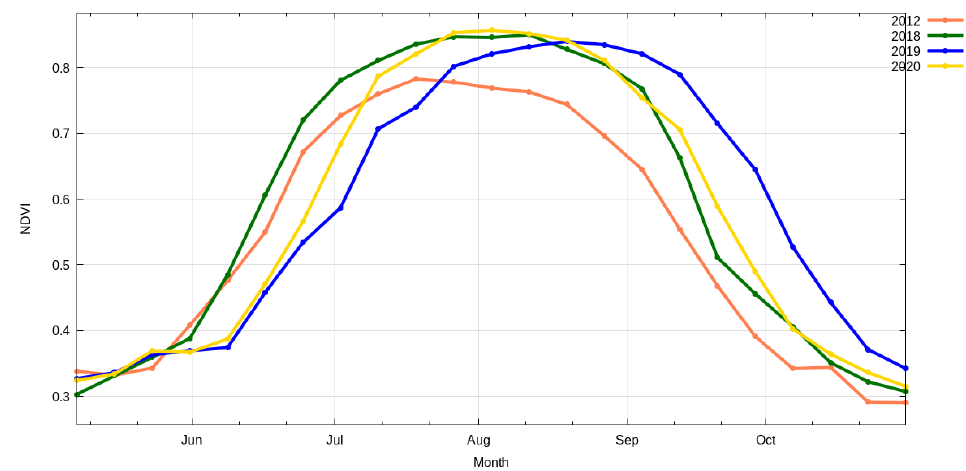
Figure 2. Average NDVI signal over corn area of the USA showing years with highest (2020: yellow), lowest (2012: orange), earliest (2018: green), and latest (2019: blue) profiles.